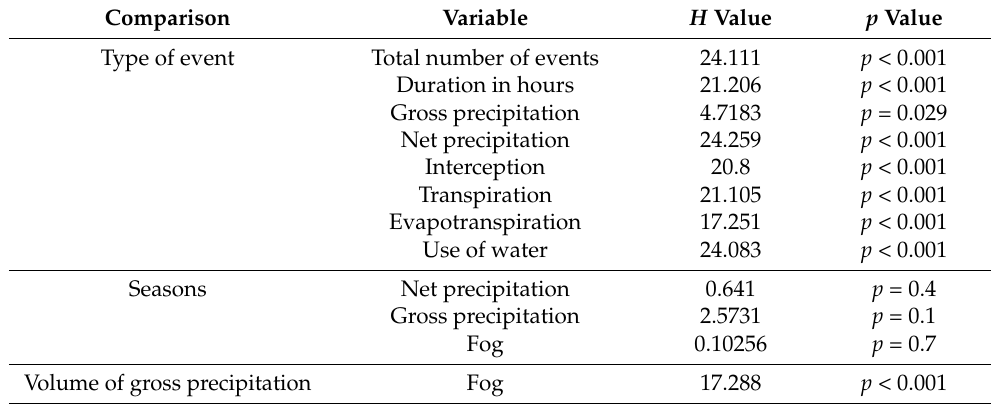
Table 3. Kruskal–Wallis results evaluating significant differences among precipitation-type events for total number of events, duration in hours, gross precipitation, net precipitation, interception, transpiration, evapotranspiration, and use of water by vegetation; between seasons (wet vs. dry) for net precipitation and gross precipitation; and among the volume of gross precipitation and fog